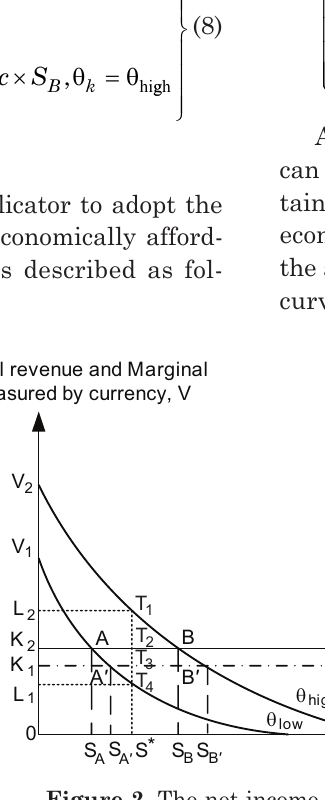
figure 2. The net income of